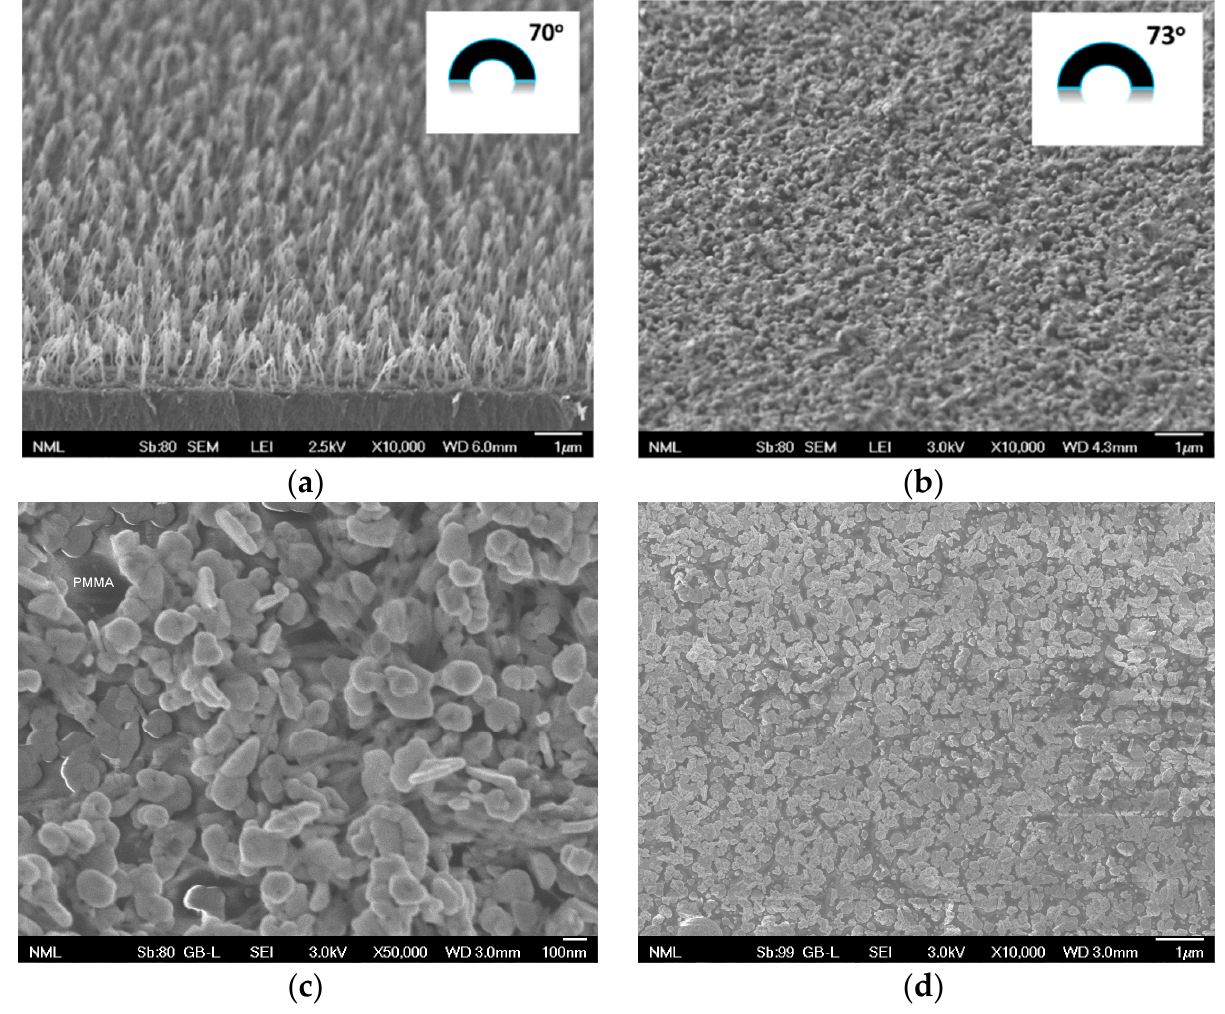
Figure 5. SEM image of: ( a ) a 3D micro-nanostructured PMMA surface, ( b ) a 3D micro-nanostructured PMMA surface after two cycles of Ag deposition, ( c ) a higher analysis image of ( b ), and ( d ) a flat PMMA surface after two cycles of Ag deposition the inserts in ( a , b ) show the corresponding water contact angles measurements performed in each surface.